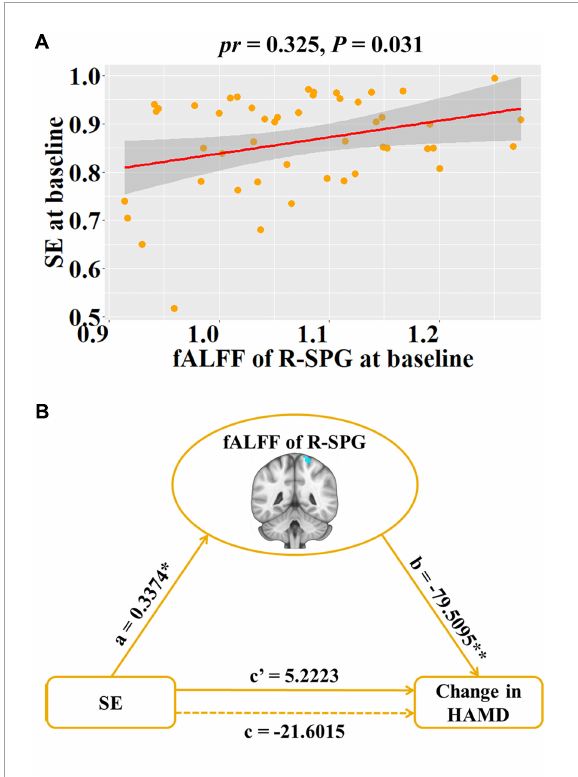
FIGURE2 Associations between baseline fALFF, baseline SE and HAMD change in patients with major depressive disorder. (A) Scatter plots of the correlation between baseline SE and the fALFF of R-SPG. (B) Graphical representation of the mediation analysis between baseline SE and HAMD change with the fALFF of R-SPG as the mediator: estimates of the mediated (a × b), direct (c’), and total (c) effects. Change = follow-up—baseline. * P < 0.05, ** P < 0.001. fALFF, fractional low frequency amplitude; SE, sleep efficiency; HAMD, Hamilton Rating Scale for Depression; R, right; SPG, superior parietal gyrus; pr , partial correlation coefficient; CI, confidence interval.